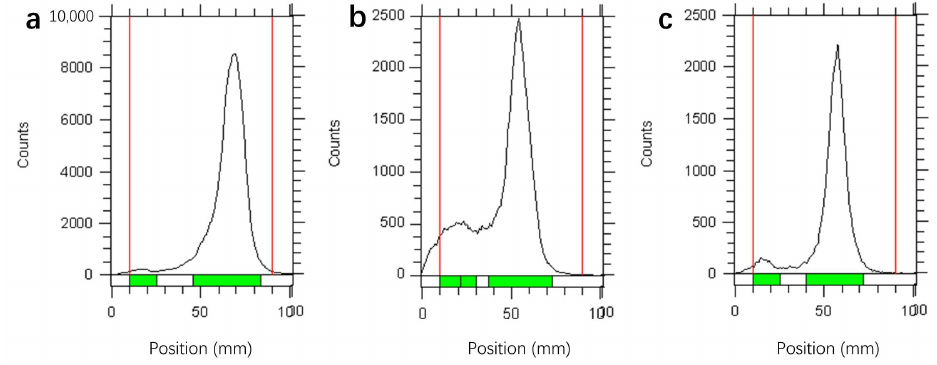
Figure 1. The initial labeling yield of 68 Ga-WL12 was analyzed by ITLC ( a ), and the stability in vitro was evaluated in FBS ( b ) and PBS ( c ) at 60 min.